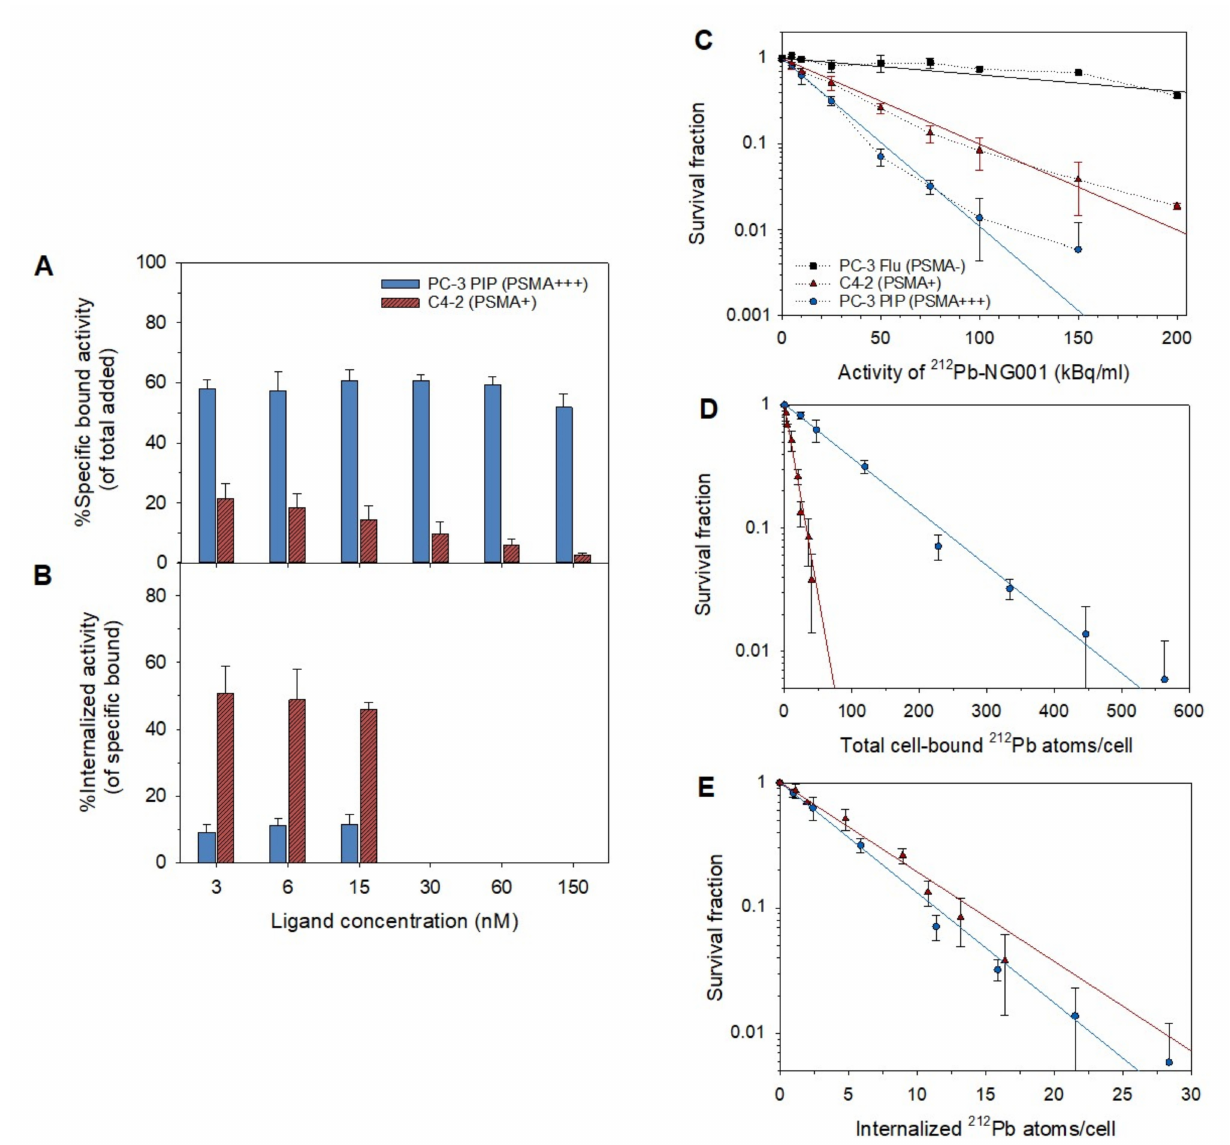
Figure 1. ( A ) Specific bound (% of total added activity) and ( B ) internalized activity (% of specific bound activity) of 212 Pb-NG001 at variable ligand concentrations in C4-2 and PC-3 PIP cells, n = 3–5. ( C ) Survival fraction of PC-3 Flu, C4-2, and PC-3 PIP cells after 1 h treatment with 212 Pb-NG001 (mean ± SD, n = 2–3) compared to untreated control cells. Survival fraction of C4-2 and PC-3 PIP cells at variable number of ( D ) bound and ( E ) internalized 212 Pb atoms/cell. The cell survival curves ( C ) were fitted by using SigmaPlot 14.5 software by the single-hit model (solid line, equation: SF = exp( − A/A 0 )), where SF is survival fraction, A is the activity (kBq/mL), and A 0 is the activity to reduce survival by 67%; dotted line, experimental data. The cell survival data ( D , E ) were fitted with single exponential